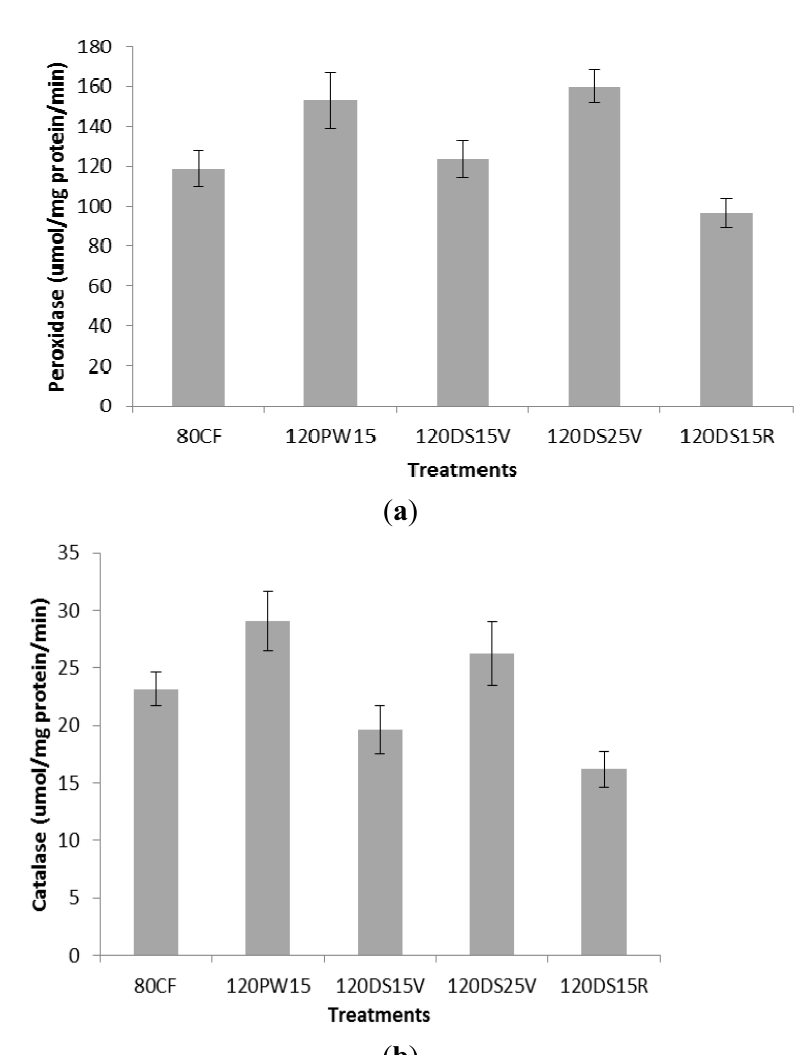
Figure 1. Impact of potassium fertilization on peroxidase activity ( a ) and catalase activity ( b ) under water stress treatments at different growth stages of rice N = 12. Bars represent standard error of differences between